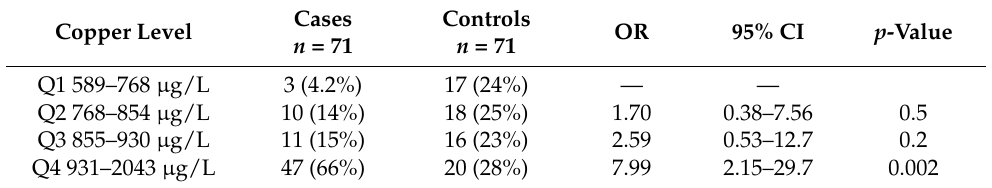
Table 7. Blood copper levels and the occurrence of stage III–IV colorectal cancer.